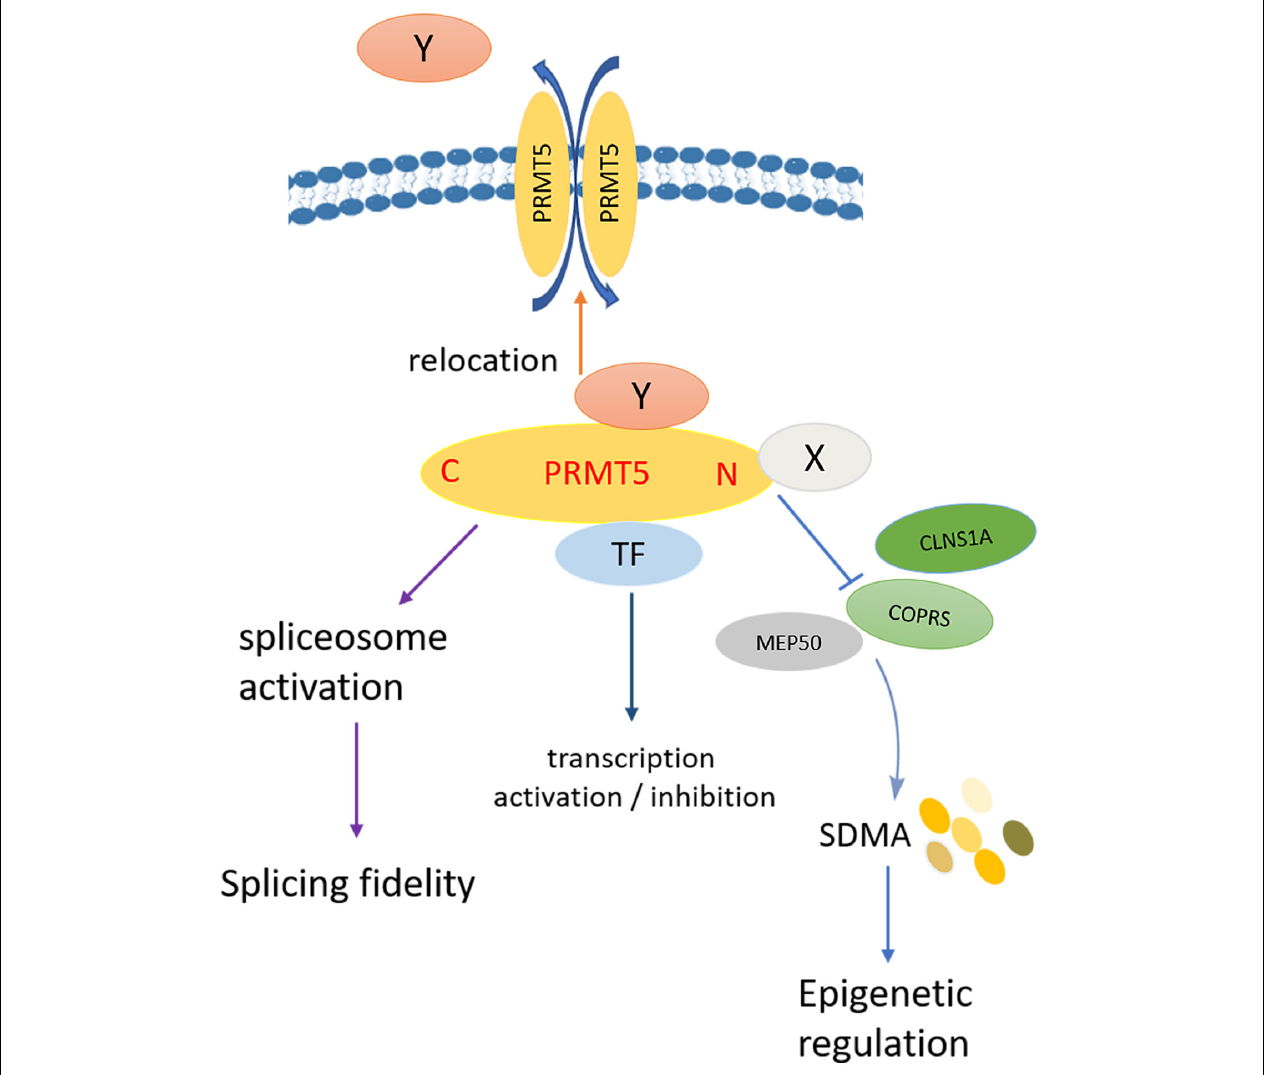
FIGURE 6 | Model diagram of PRMT5 regulating biological functions. Firstly, PIPs directly bind to the N-terminal of PRMT5, which competitively destroys the binding of PRMT5 to COPRS, leading to the change of histone and non-histone arginine residues SDMA level; secondly, PRMT5 binds to transcription factors to play roles in transcription activation or inhibition; thirdly, as a splicing modulator, PRMT5 mediates spliceosome activation, and regulates the fidelity of splicing; fourthly, PIPs affect the subcellular localization of PRMT5, nuclear PRMT5, and cytoplasmic PRMT5 play opposite roles in cell proliferation; at the same time, PRMT5 also affects the subcellular localization of PIPs by methylation of arginine